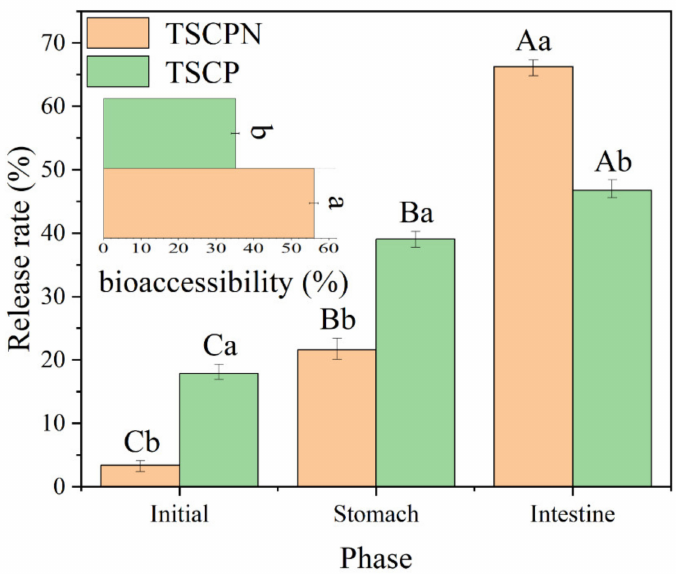
Figure 7. Lutein release rates (vertical bar graphs) of TSCPN-stabilized Pickering emulsions and TSCP-stabilized emulsions at initial stage, post-gastric, and post-intestinal; TSCPN-stabilized Picker- ings and TSCP-stabilized post-intestinal Lutein bioaccessibility of emulsion delivery (horizontal bar graph). Different lowercase letters indicated significant differences between TSCPN-stabilized Picker- ing emulsion and TSCP-stabilized emulsion ( p < 0.05), different capital letters indicate significant difference among different digestion phases ( p <